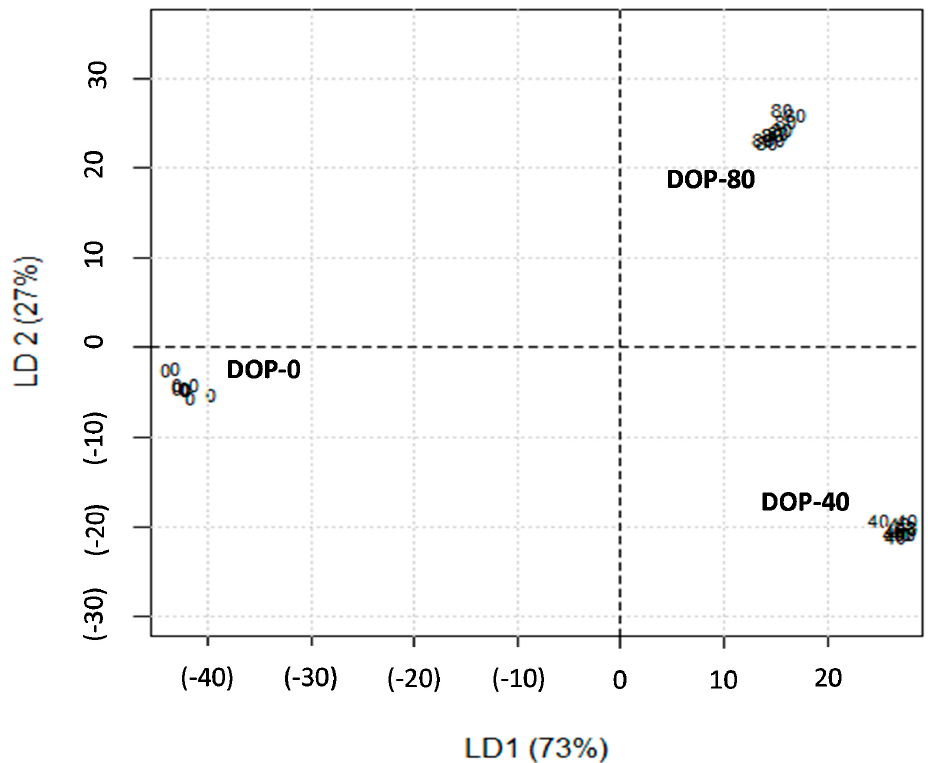
Figure 1. Analysis of observed variables that discriminate the meat of suckling kid goats from three dam diet treatments: commercial concentrates with alfalfa hay (DOP ‐ 0), concentrate including 40% of replacement of cereals by pellets of dehydrated orange pulp and alfalfa hay (DOP ‐ 40), and concentrate including 80% of replacement of cereals by pellets of dehydrated orange pulp and alfalfa hay (DOP ‐ 80).